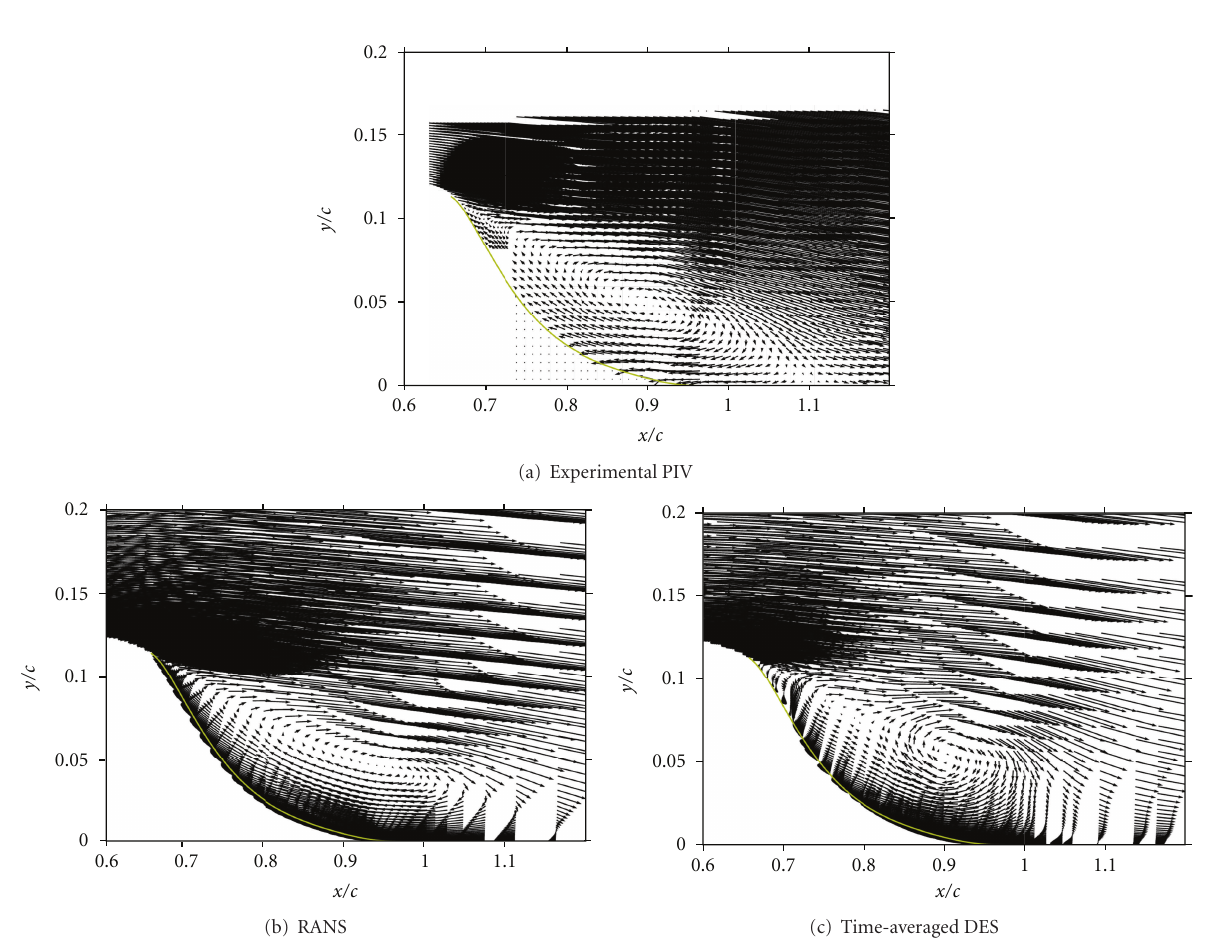
Figure 9: Comparison of U -velocity